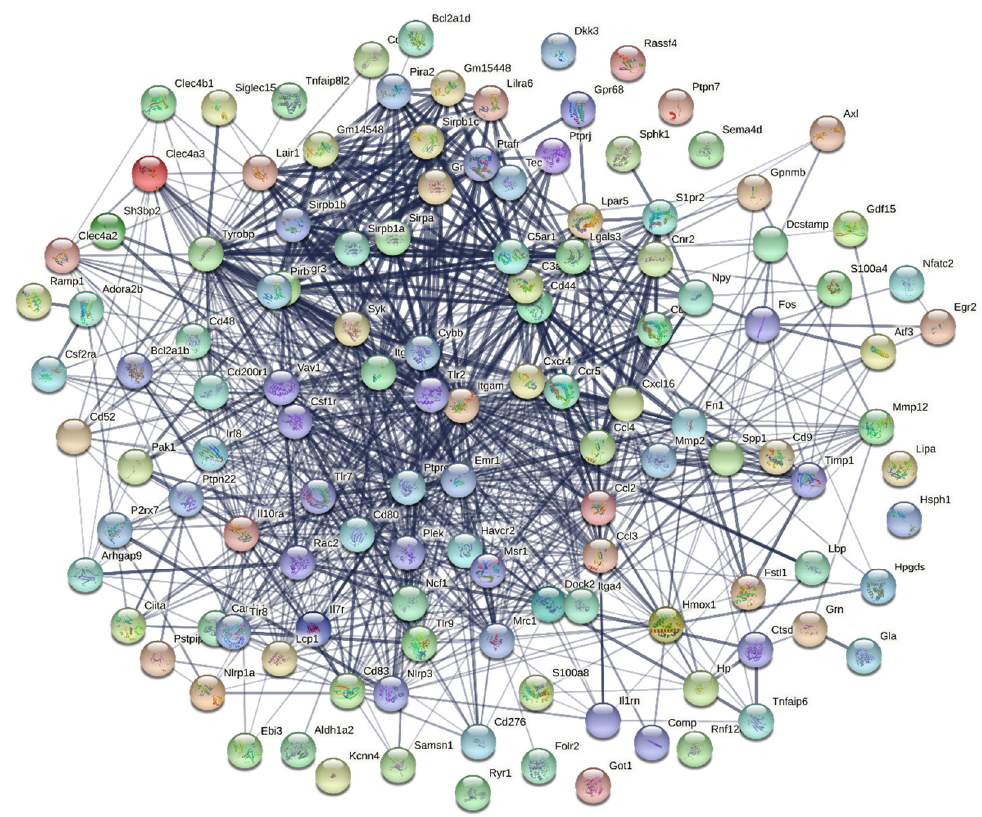
Figure 6. Protein–protein interaction network between 126 down-regulated immune-suppressor genes.